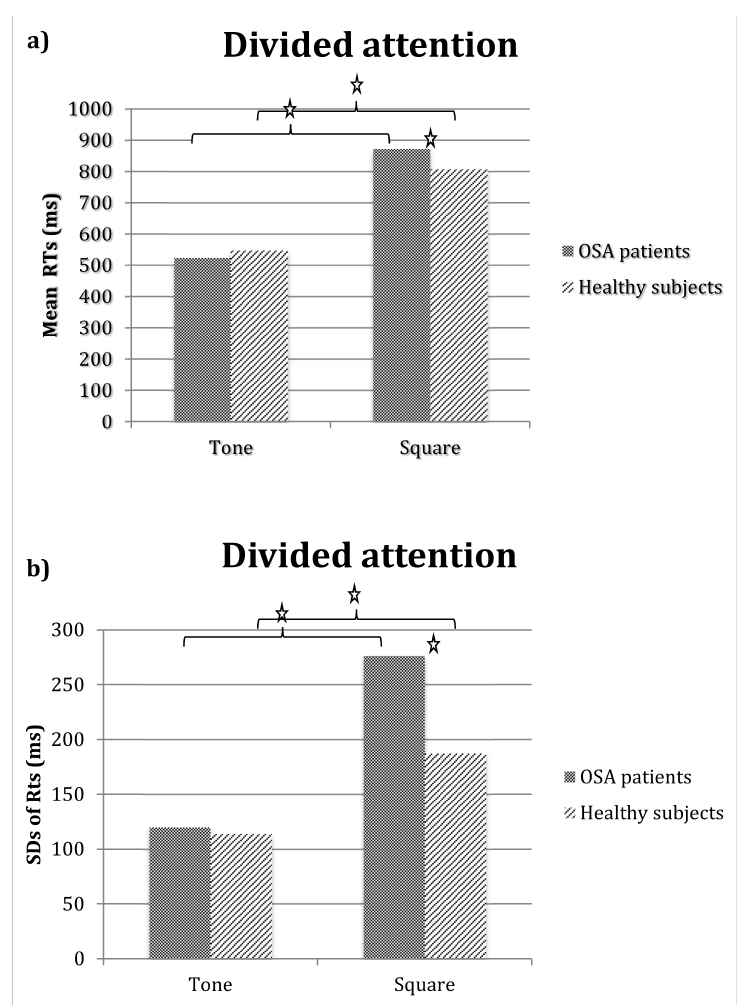
Figure 6. Mean reaction times ( panel a ) and standard deviations of reaction times ( panel b ) of OSA patients and controls in auditory and visual tasks of divided attention test. Legend: Stars indicate significant di ff